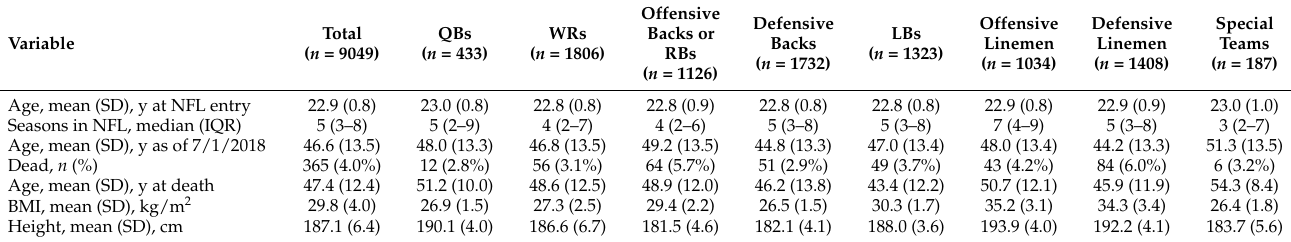
Table 1. National Football League Player Demographics (Players Entering 1970–2017; n = 9049).